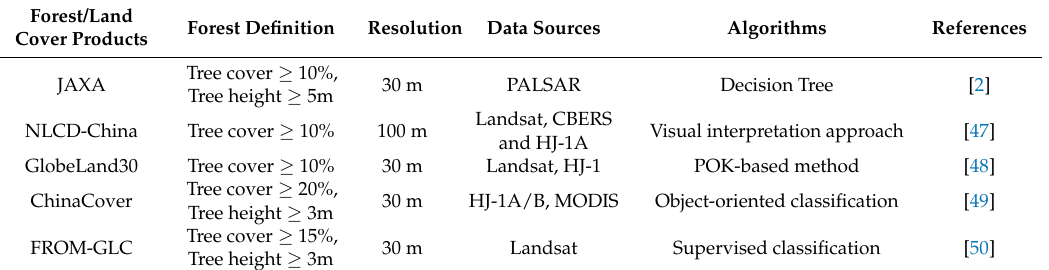
Table 1. A brief summary of five moderate resolution forest maps in this